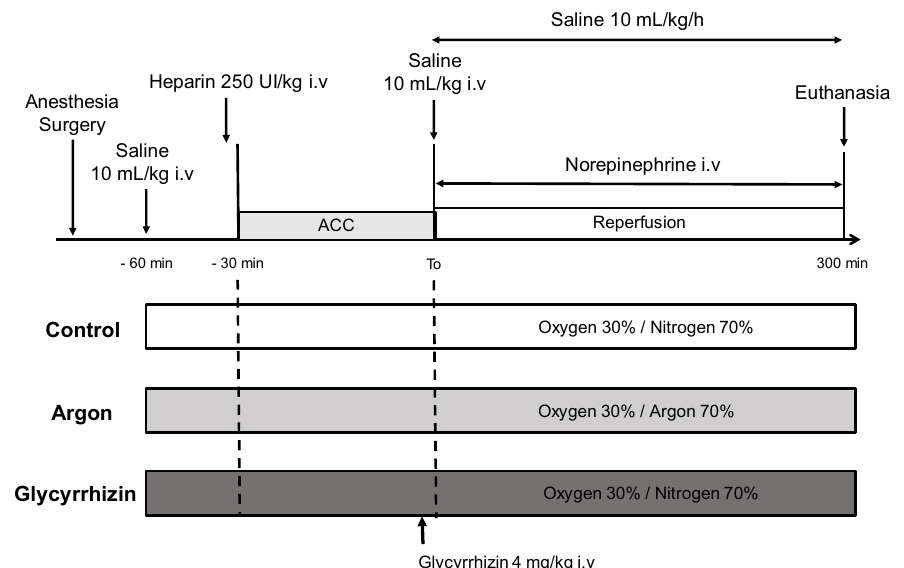
Figure 1. Schematic representation of the experimental protocol. ACC: aortic cross-clamping; Control ( n = 7 ), Argon ( n = 7), Glycyrrhizin ( n = 7).